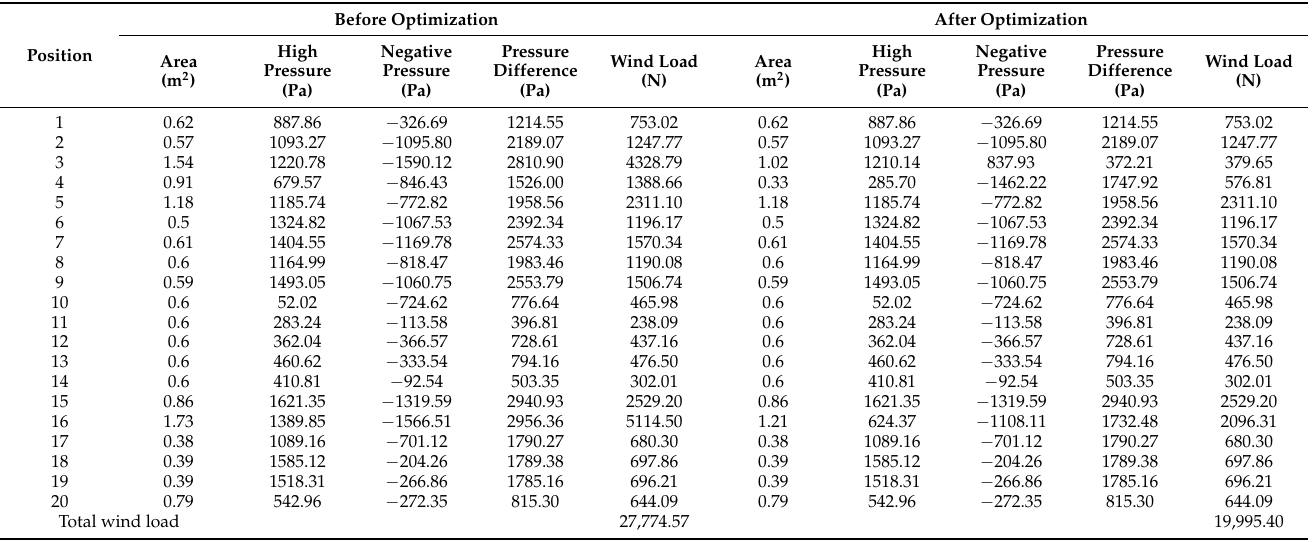
Table 9. The data before and after optimization for the LNG unloading arm.